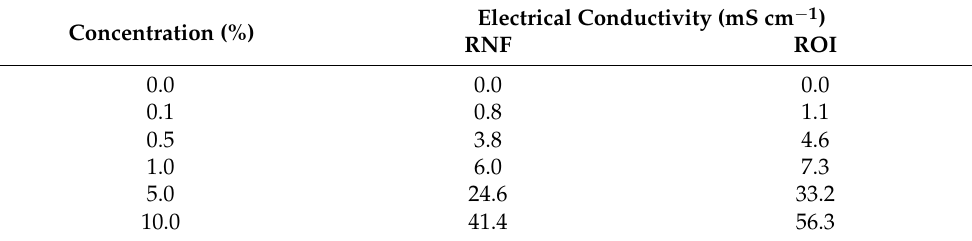
Table 1. Electrical conductivity of RNF and ROI concentrations. Concentration